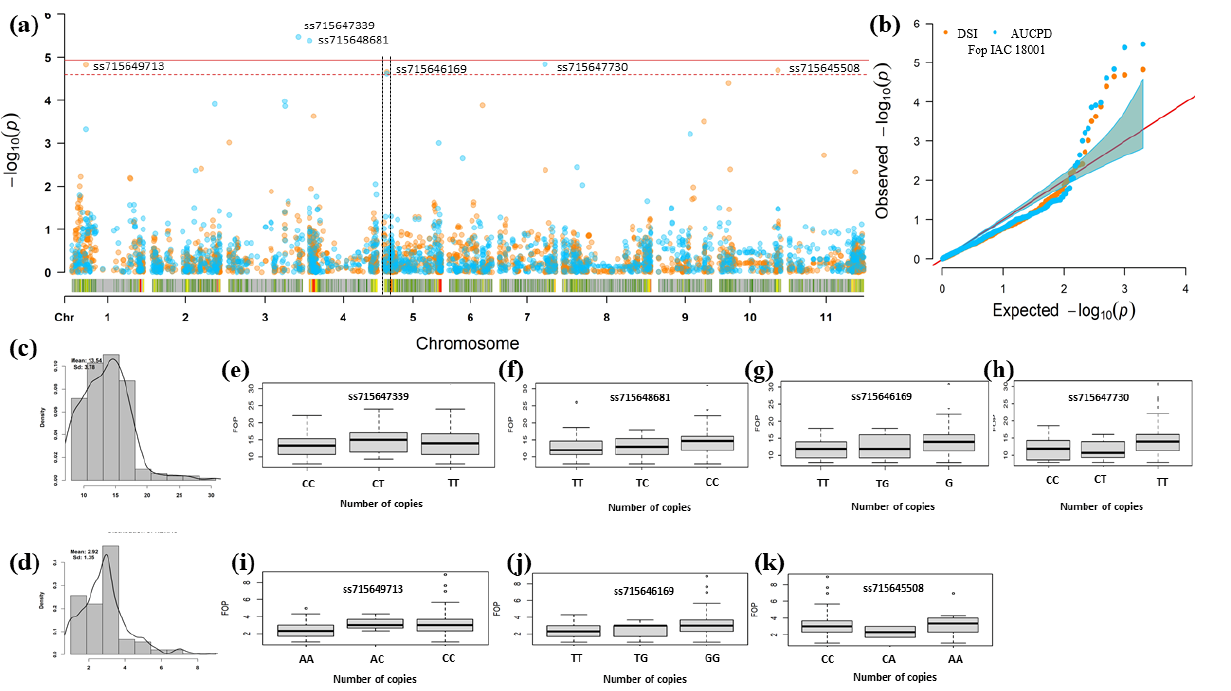
Figure 6. GWAS for Fop resistance in the MDP with 205 common bean genotypes with significant SNPs for the IAC18001 strain using the DSR and the AUDPC parameters and FarmCPU. ( a ) Manhattan plots and ( b ) Q-Q (Quantile-quantile) plots, with orange circles representing the p values for DSR and blue circles the p values for AUDPC. The dotted red line corresponds to the cut-offline obtained by the resampling method − log10(p) = 4.48 × 10 − 5 , and the upper red line refers to the cut-offline obtained by the Bonferroni method ( α = 0.05). ( c , d ) Histograms of adjusted phenotypic means (BLUE) of AUDPC and DSR. ( e – k ) Boxplots of the relationship between the allele and phenotype ( Fop resistance) of each significant SNP for DSR and AUDPC.